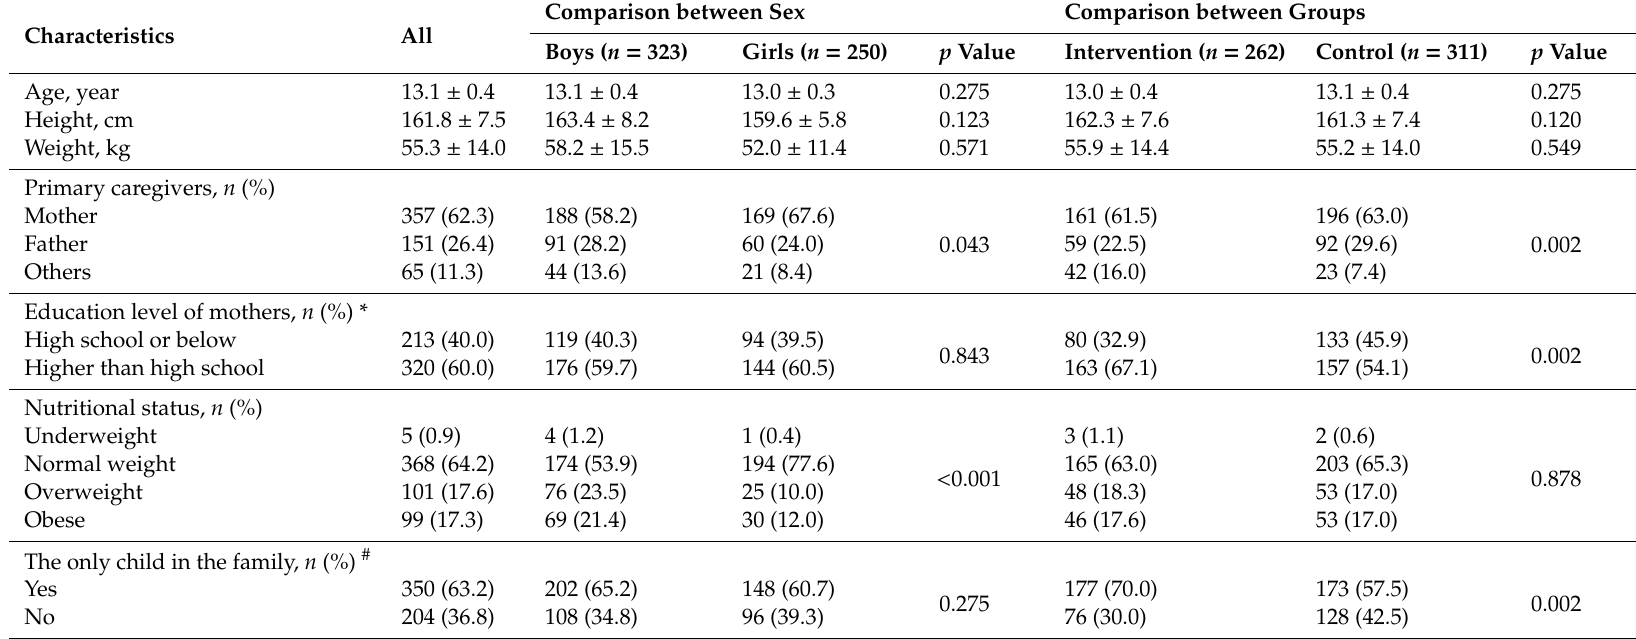
Table 1. Baseline characteristics, overall and by sex and study arms ※